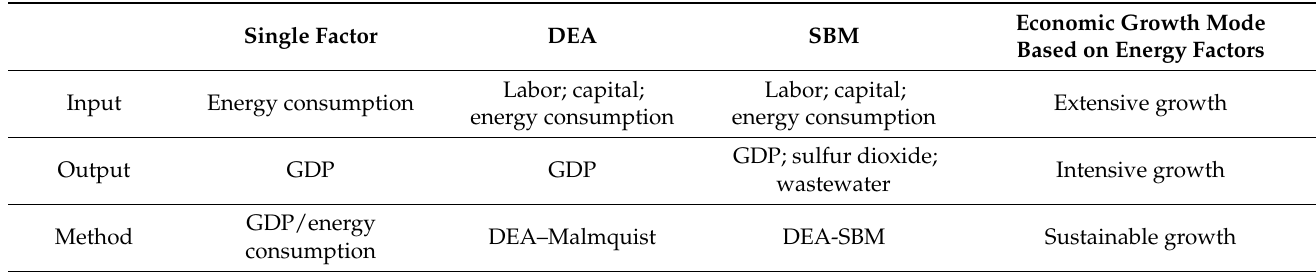
Table 1. Energy productivity measurement method.